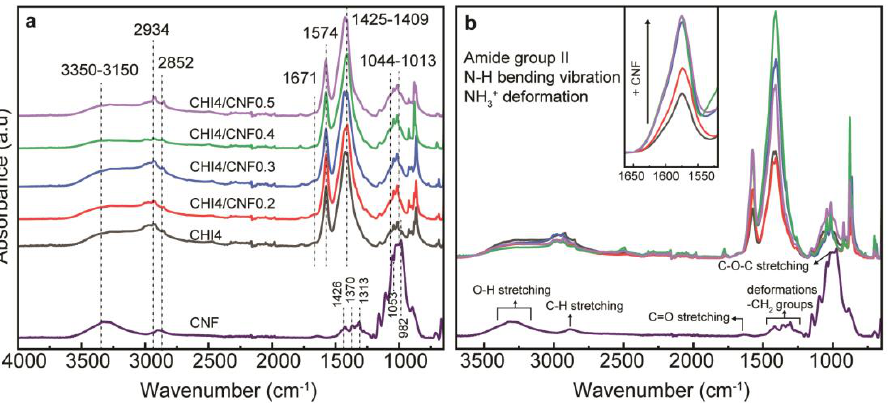
Figure 6. ( a ) ATR-FTIR spectra of CHI/CNF spun fibers, with the reference spectrum of the CNF alone. ( b ) Closer view to the amide II band region around 1550 – 1650 cm −1 , after comparison of all FTIR spectra as in ( a ).